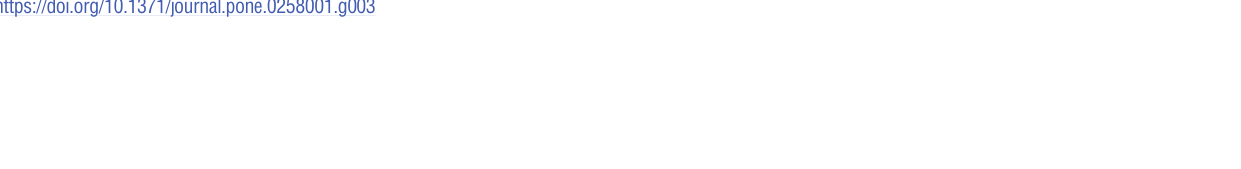
PLOS ONE | https://doi.org/10.1371/journal.pone.0258001 September 30,